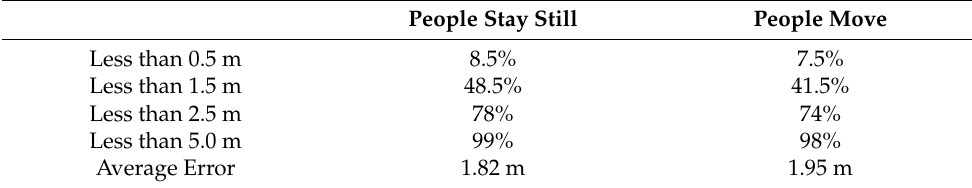
Figure 9. Errors when people stay still (static), and when people move (dynamic). Table 6. Detailed information of errors when people move and stay still. People Stay Still People Move Less than 0.5 m 8.5% 7.5% Less than 1.5 m 48.5% 41.5% Less than 2.5 m 78% 74% Less than 5.0 m 99% 98% Average Error 1.82 m 1.95